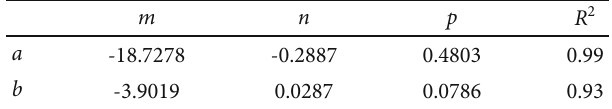
Table 6: Quadratic fi tting parameters for a and b